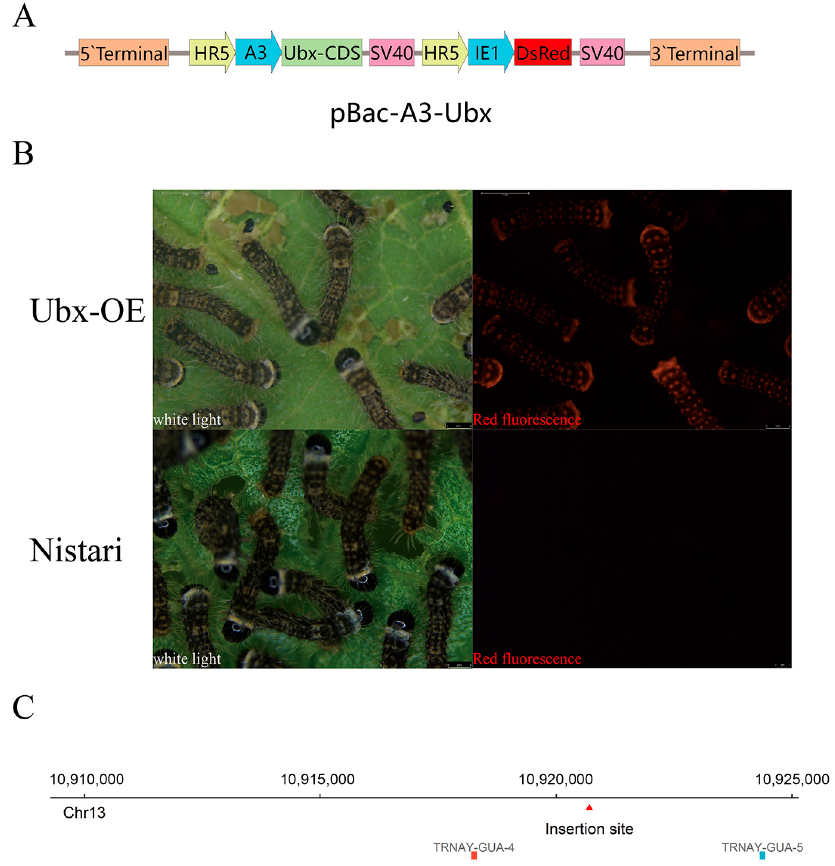
Figure 1. Construction of overexpressed Ubx silkworm. ( A ) The schematic diagram of Ubx over- expression plasmid. A3-promoter, the promoter of Actin3 ; Ubx-CDS, the coding sequence of Ubx ; DsRed2, the red fluorescent protein gene. ( B ) The ant silkworms of Ubx OE with red fluorescent protein (RFP) gene and Nistari (no RFP) under white light conditions and 532 nm red fluorescent excitation light. The scale bar in the lower right of pictures shows 1 mm. ( C ) Relative position of Ubx overexpression plasmids inserted site (red arrow) on genome of Bombyx mori . Ubx-OE, the transgenic strain with Ultrabithorax overexpressed, namely Ubx OE . Nistari, the control of Ubx OE